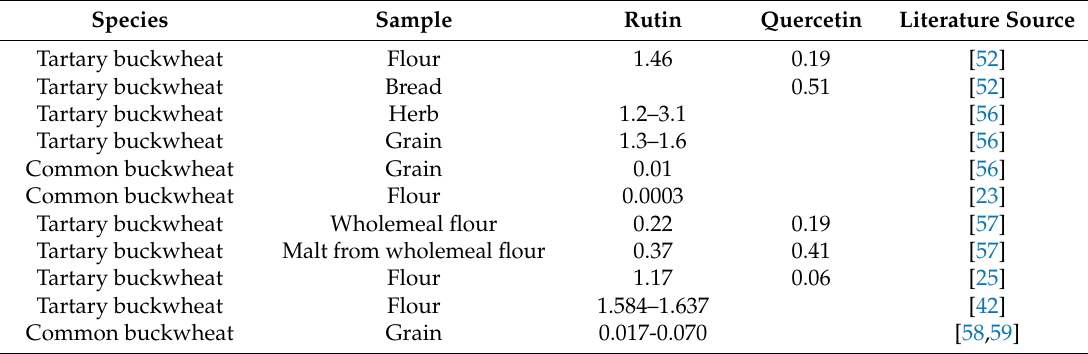
Table 1. Rutin and quercetin content in common and Tartary buckwheat grain and products (in g / 100g dry